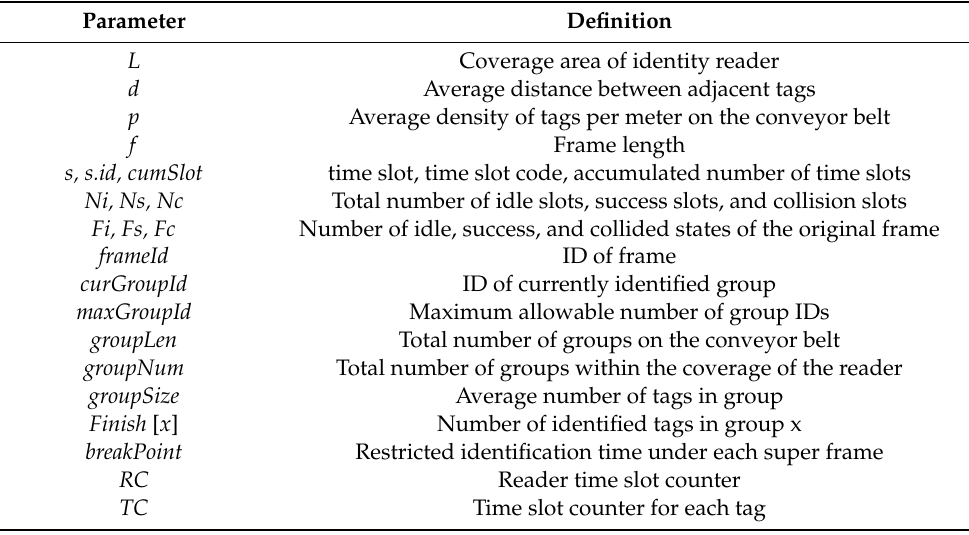
Table 1. Definition of related